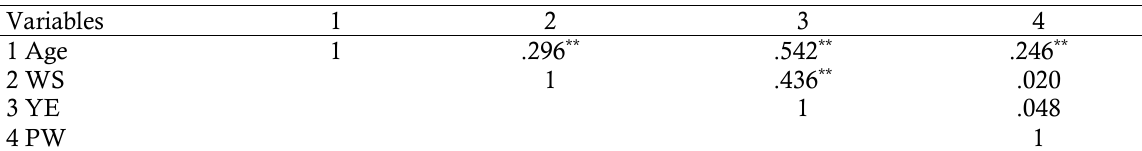
Table 2. variables inter-correlation Variables 1 2 3 4 1 Age 1 .296 ** .542 ** .246 ** 3 YE 1 .048 4